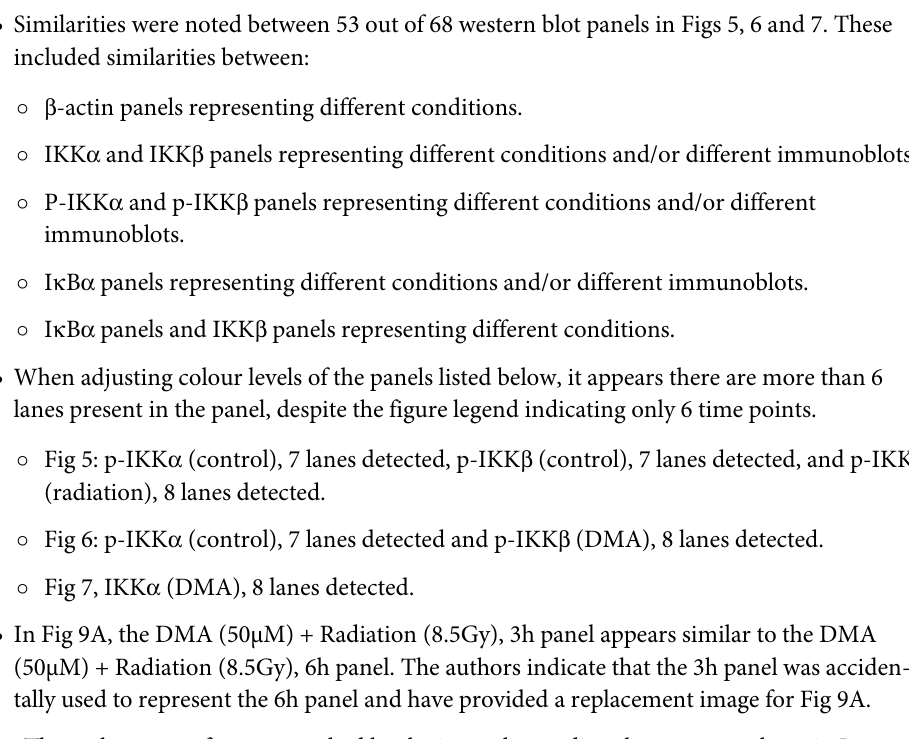
� Fig 5: p-IKK α (control), 7 lanes detected, p-IKK β (control), 7 lanes detected, and p-IKK β (radiation), 8 lanes detected. � Fig 6: p-IKK α (control), 7 lanes detected and p-IKK β (DMA), 8 lanes detected. � Fig 7, IKK α (DMA), 8 lanes